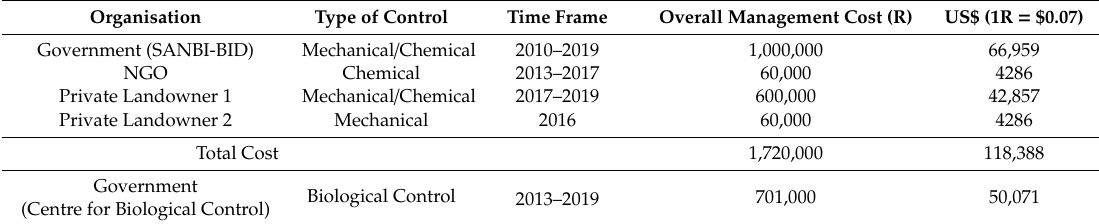
Table 3. The total management cost of Sagittaria platyphylla in South Africa from 2010 to